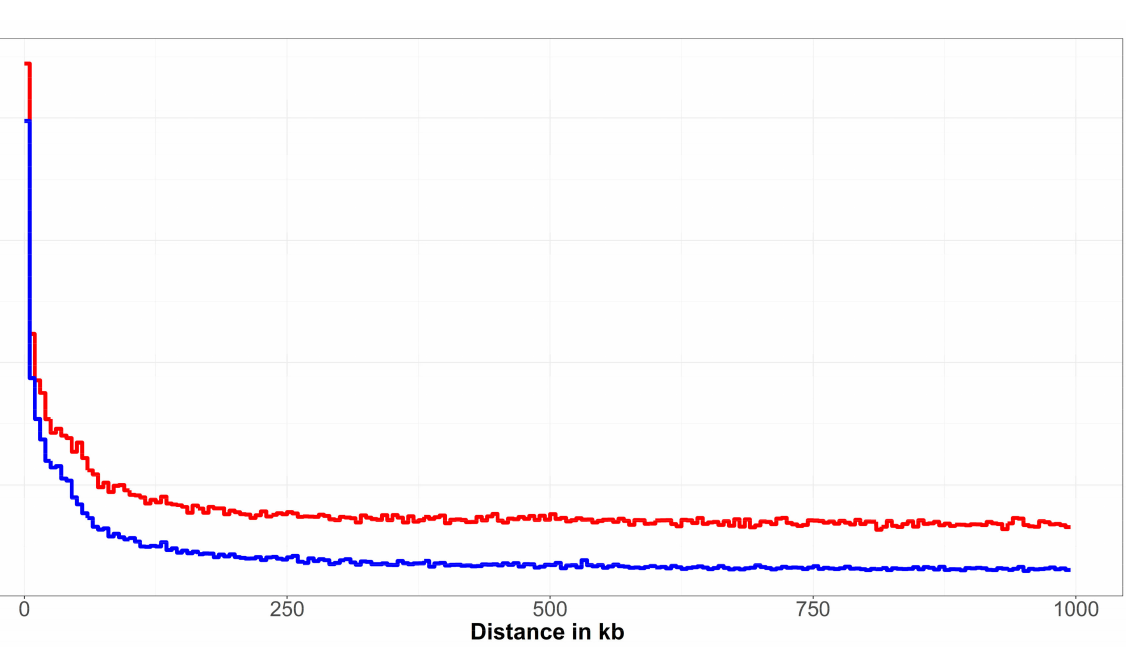
Figure 3. Linkage disequilibrium decay in the Original Valachian (red line) and Improved Valachian (blue line) sheep